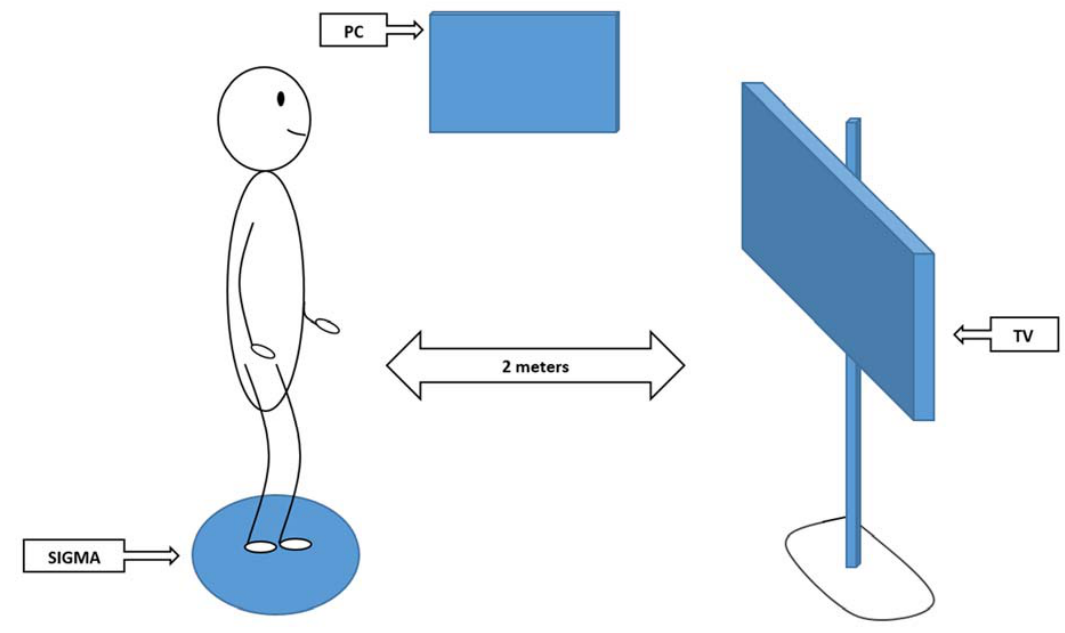
Figure 5. Correct position during a training session on SIGMA balance platform.